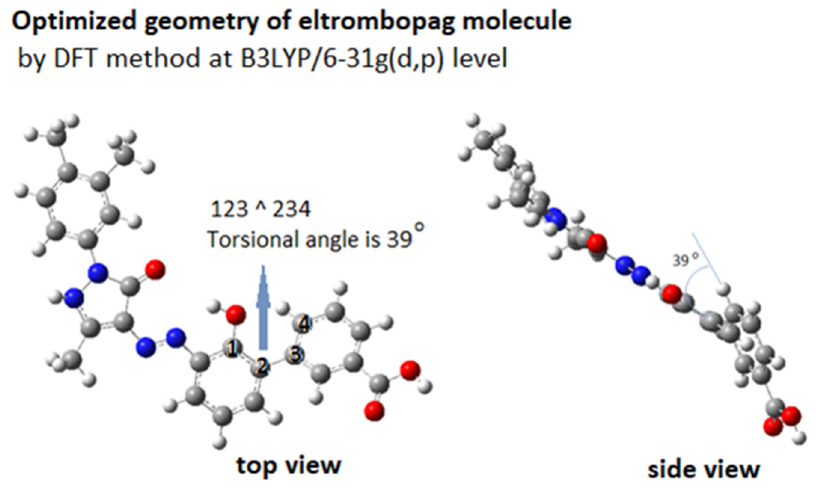
Figure 11. 3D structure of ELT molecule.